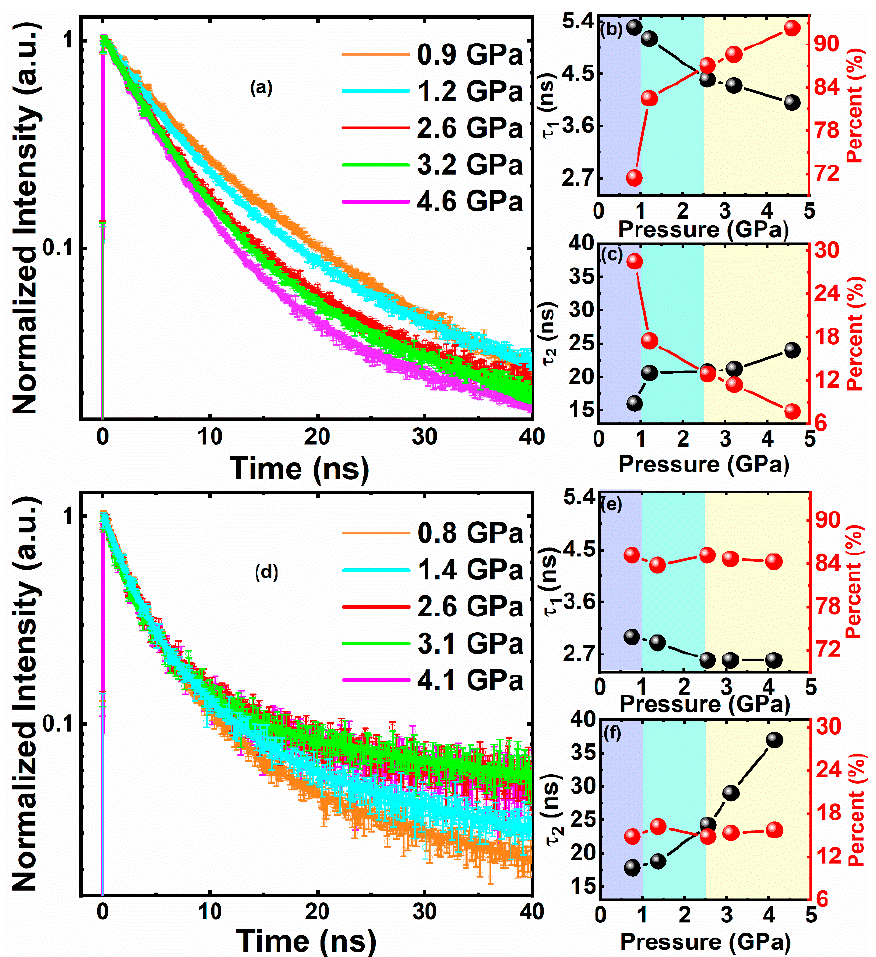
Figure 4. ( a , d ) Normalized pressure-dependent PL lifetime of CdSe/ZnS–QDs and CdSe/ZnS–QDs– PMMA, respectively. ( b , e ) Functional relationship between pressure and τ 1 (percent) of CdSe/ZnS– QDs and CdSe/ZnS–QDs–PMMA, respectively. ( c , f ) Functional relationship between pressure and τ 2 (percent) of CdSe/ZnS–QDs and CdSe/ZnS–QDs–PMMA, respectively.